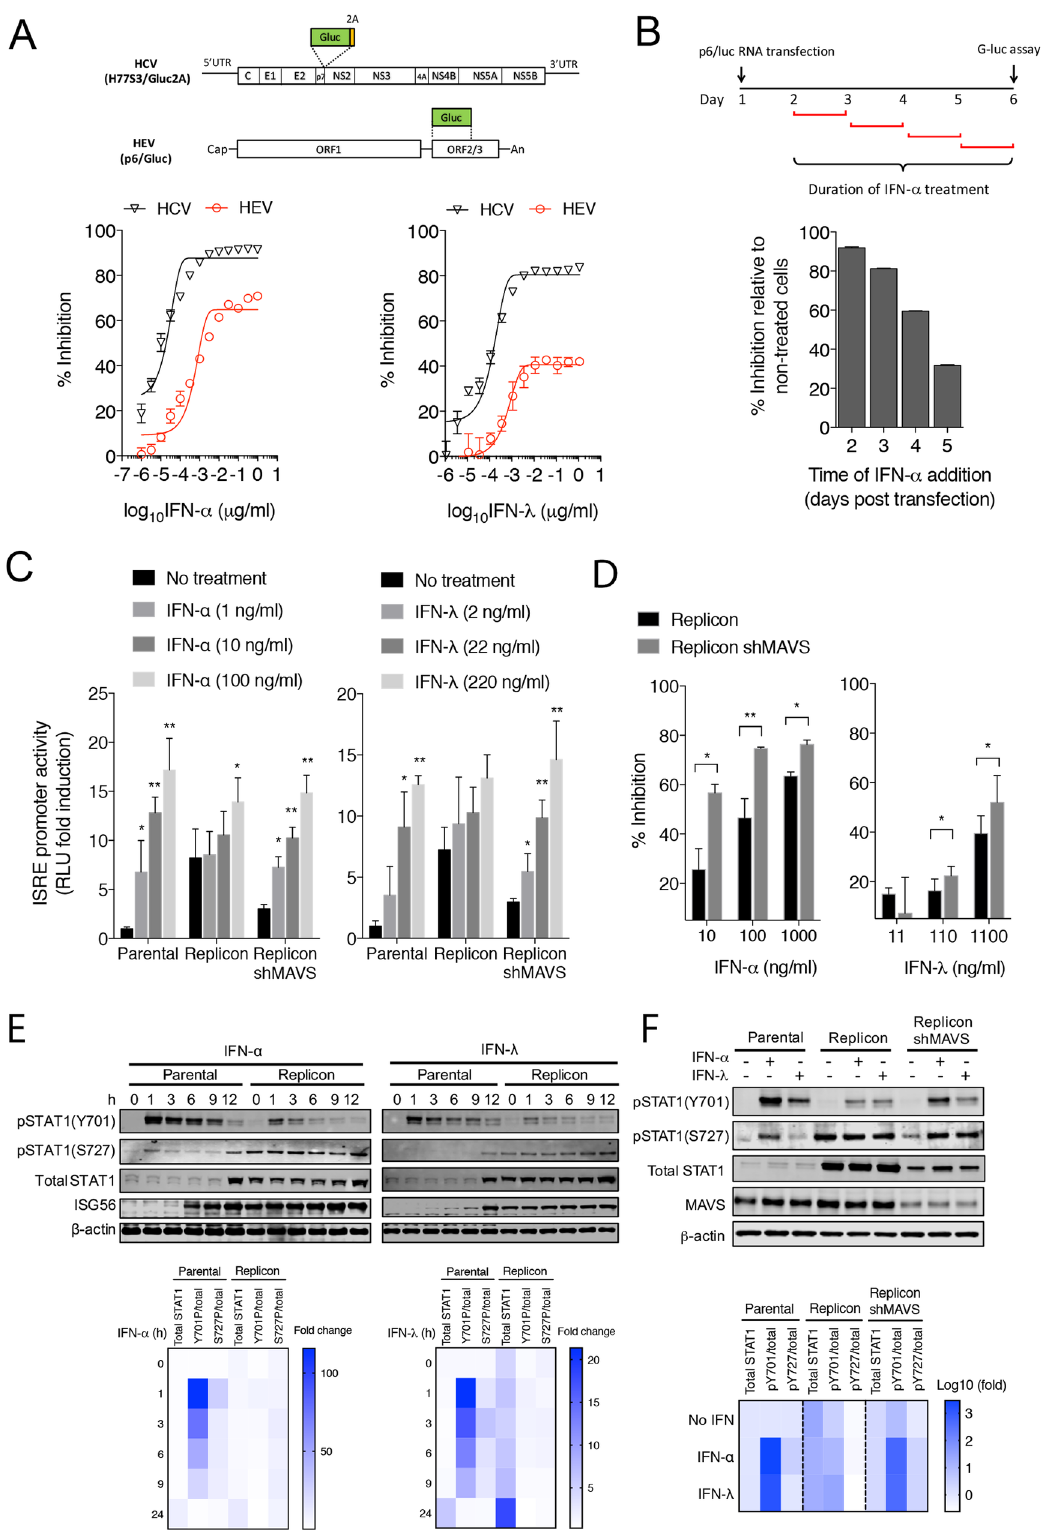
Fig 5. HEV-infected cells are refractoryto exogenous IFNs due to basal activation of the JAK/STAT signaling. (A) Comparison of antiviral effect of IFN- α and IFN- λ on HCV and HEV replication.Top, a schematic diagramof HCV